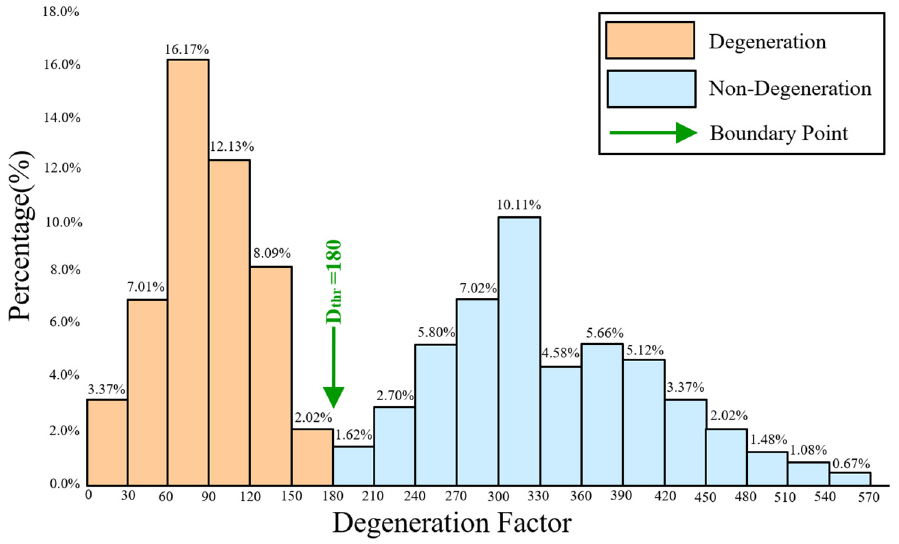
Figure 4. The statistical result of degeneration factor.